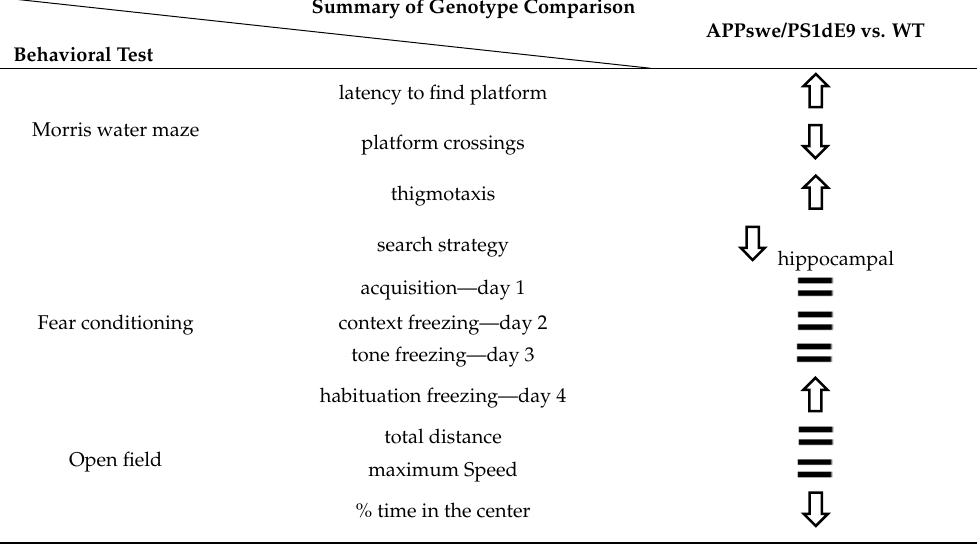
Table 1. Summary of the behavioral pro fi le of 9-month-old female APP/PS1 mice.